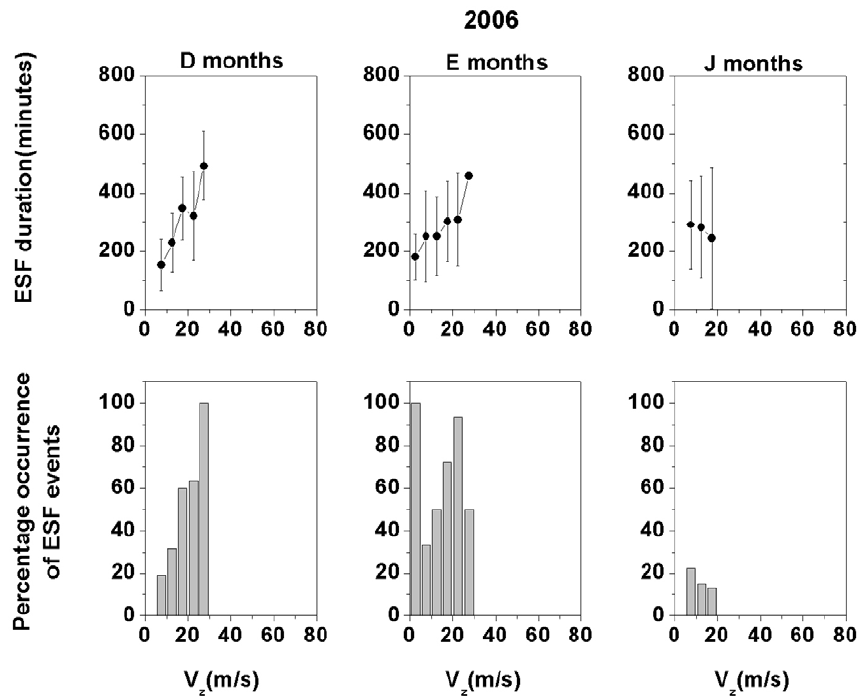
Fig. 2b. Same as for Fig. 2a, but for the solar minimum year of